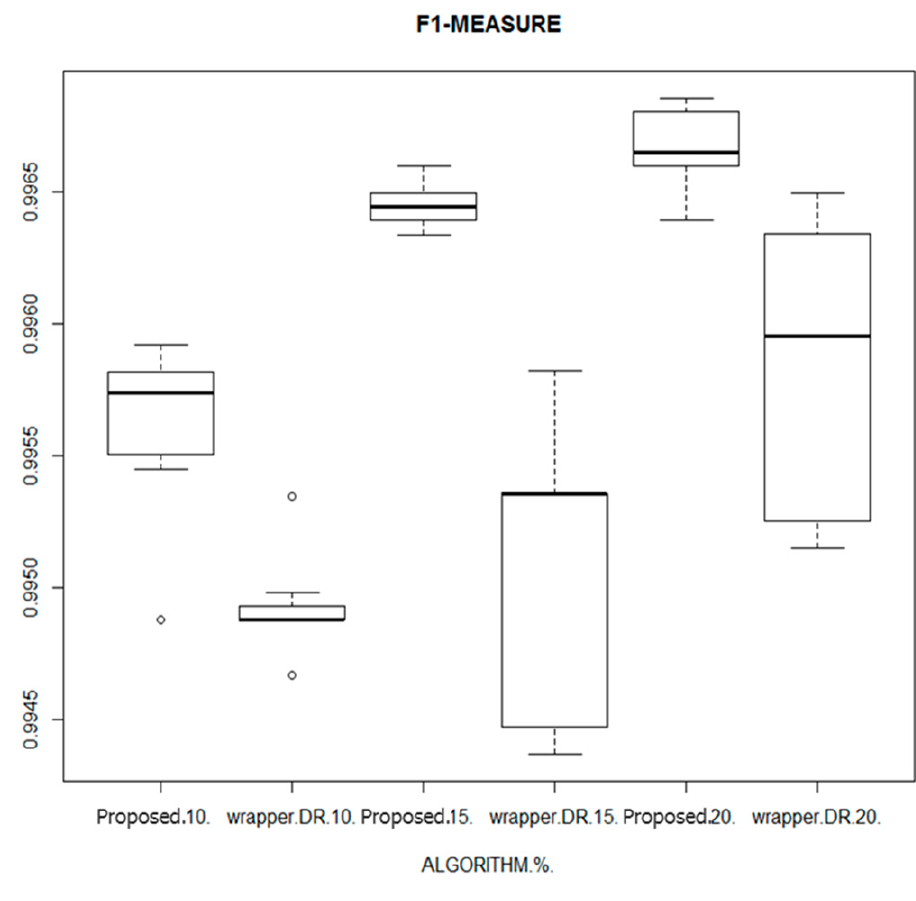
Figure 7. Result of F1-measure: box plot.